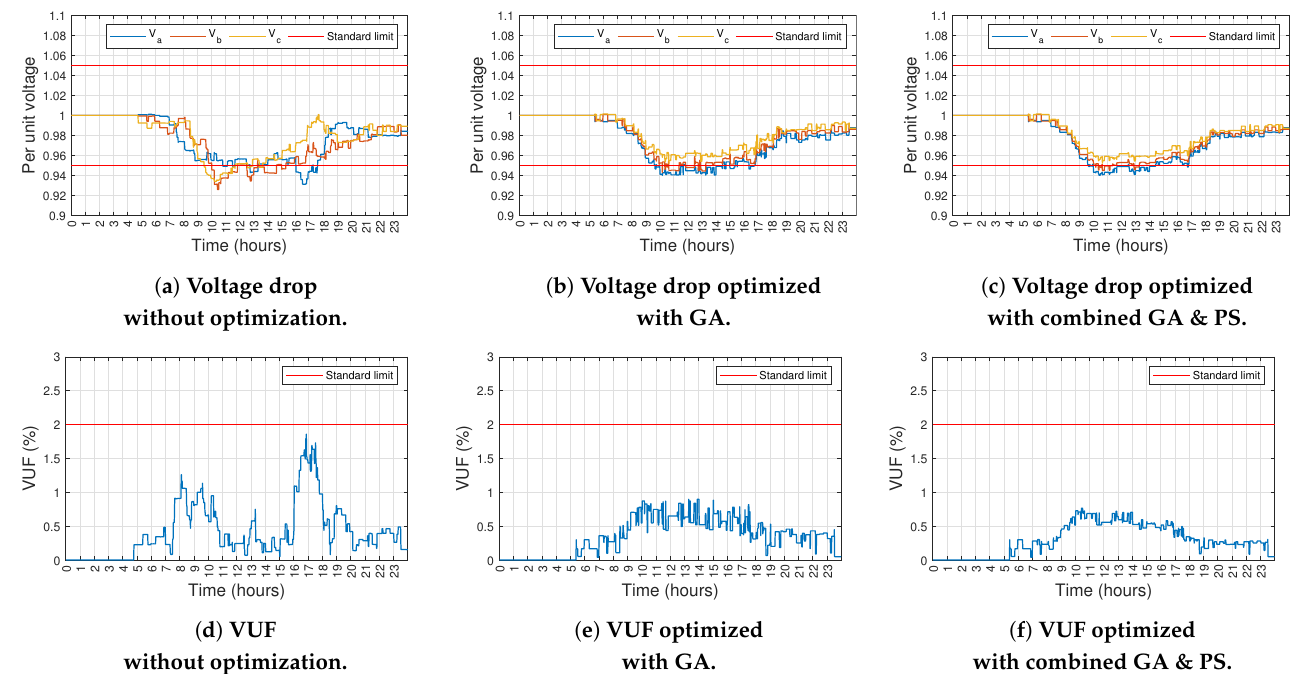
Figure 17. Voltage drop and the VUF at the bus ca4 for three cases. ( a ) Voltage drop without optimization. ( b ) Voltage drop optimized with GA. ( c ) Voltage drop optimized with combined GA & PS. ( d ) VUF without optimization. ( e ) VUF optimized with GA. ( f ) VUF optimized with combined GA &